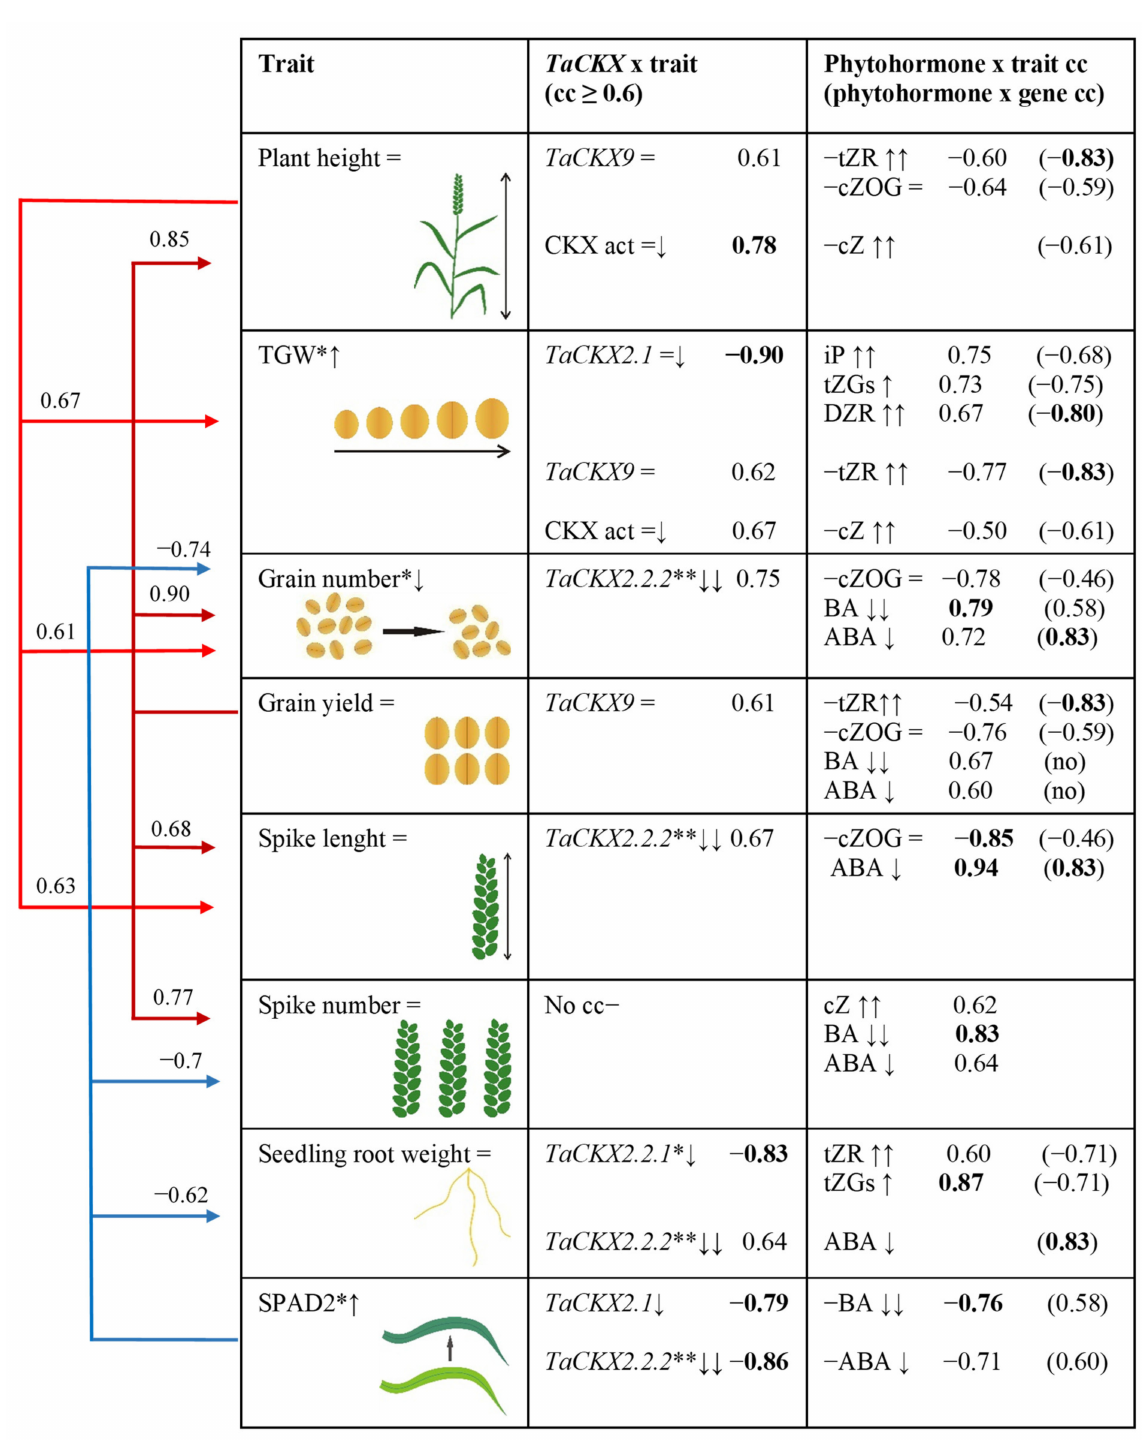
Figure 6. Effect of increased ( ↑ ), decreased ( ↓ ) or unchanged (=) expression of TaCKX GFMs as well as phytohormones in 7 DAP spikes on yield-related traits based on correlation coefficients (cc). Red arrows—positive cc; blue arrows—negative cc. Values of cc in bold are significant at p < 0.05; no—no correlation; = ↓ slightly silenced; ↓↓ highly silenced. *—significant at p ≤ 0.05; **—significant at p ≤